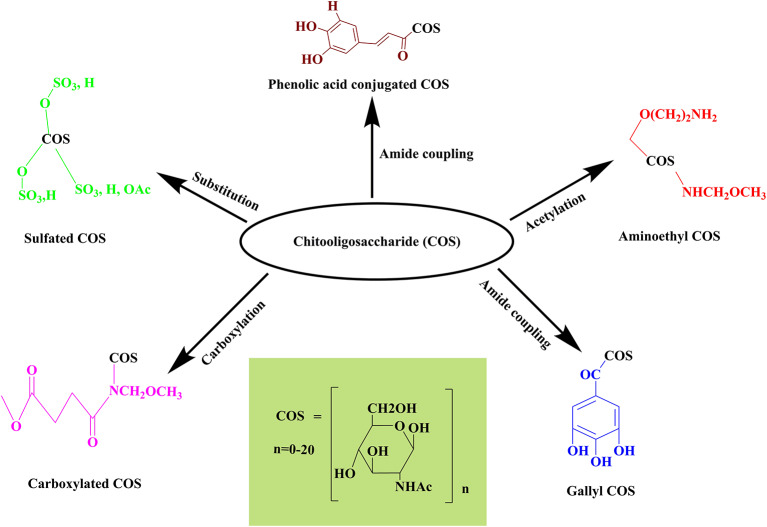
Representation of the mechanism involved in COS and GlcNAc generation through ionic liquid.